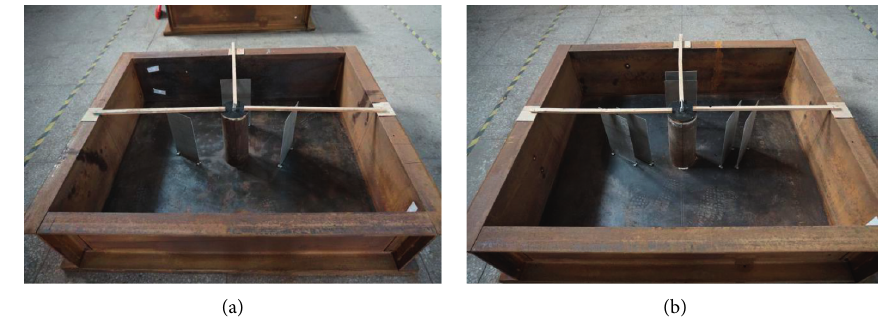
Figure 12: Layout of the joints in the model test samples. (a) T1 sample. (b) T2 sample.